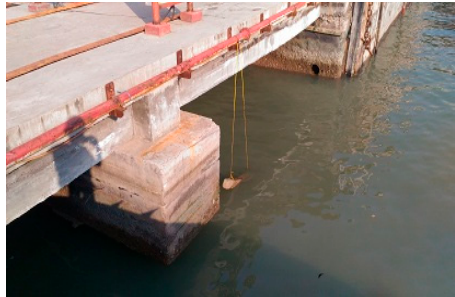
Figure 4. Geopolymer concrete beam cured in seawater for 28 days.